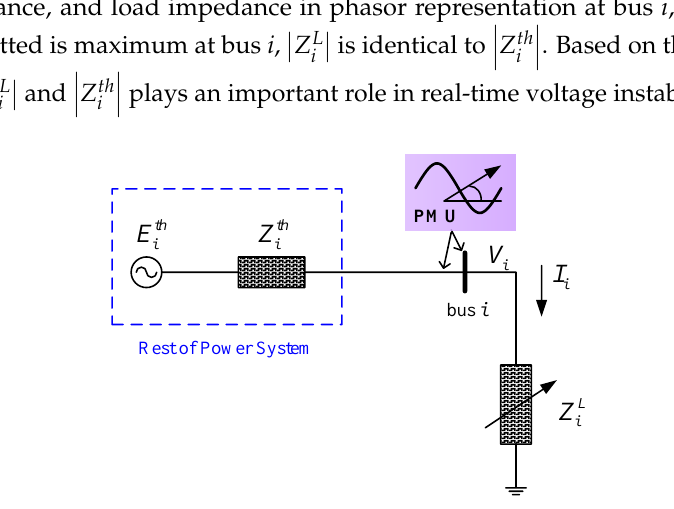
Figure 4. Thevenin equivalent network at bus i with PMU installed.